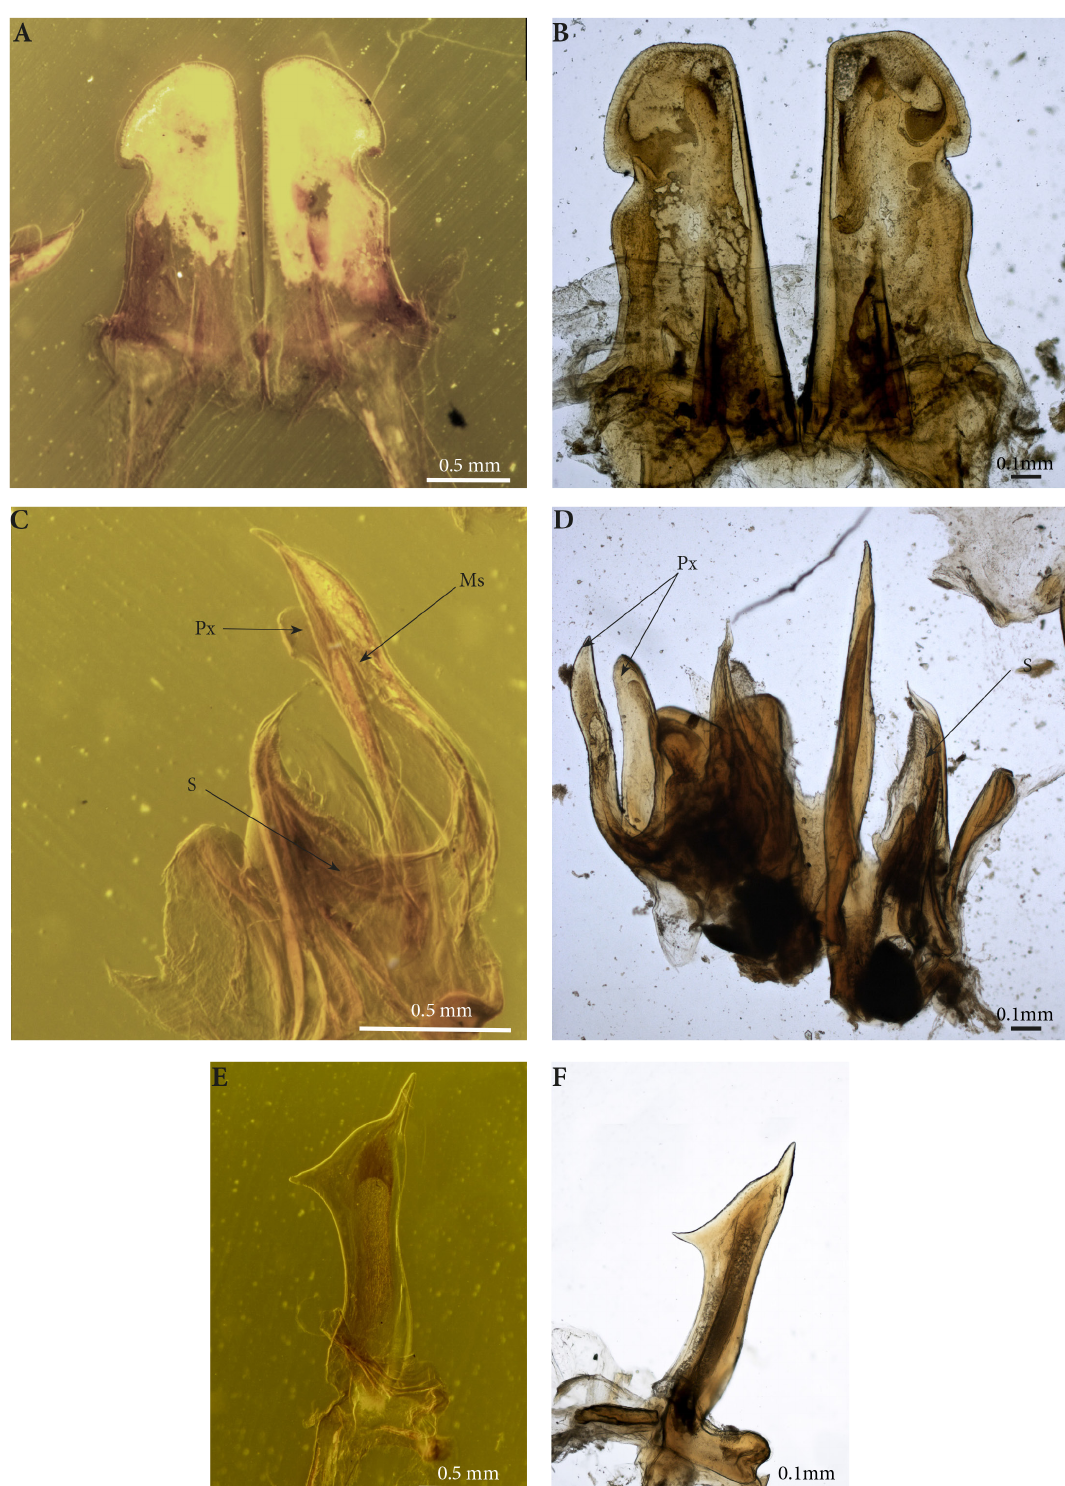
Fig. 15. Ommatoiulus lusitanus (Verhoeff, 1895). A , C , E . ‘ Archiulus cingulatus ’ syntype (NHMW 3162). B , D , F . Schizophyllum ( Eleutheroiulus ) lusitanum , syntypes, slide preparation (ZMB 130856). A–B . Promerites, posterior view. C–D . Posterior gonopods, posterior view. E–F . Mesomerites, posterior